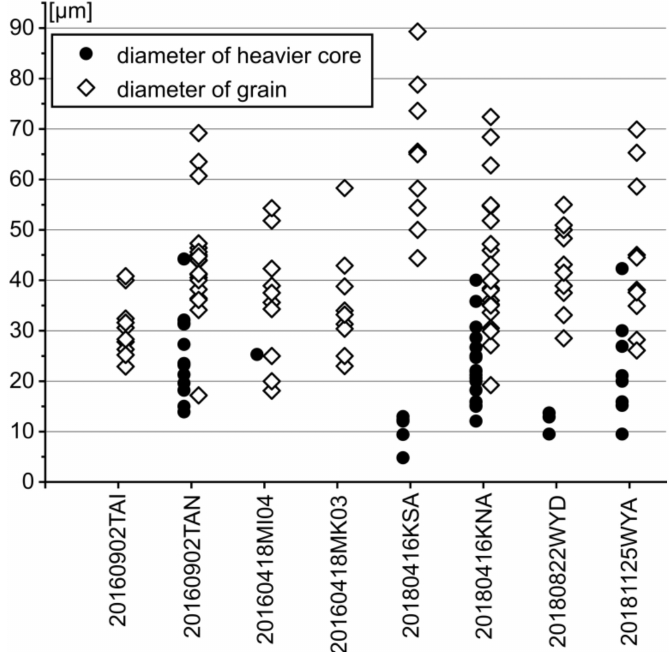
Figure 8. Diameter of garnet grain and Mn-rich core. The number of plots for the diameters of Mn-rich cores is fewer since it is not plotted when the Mn-rich core is not observable on the BEI. The size of the Mn-rich cores is relatively small in samples 20180416KSA and 20180822WYD. Mn-rich cores are not observed in samples 20160902TAI and